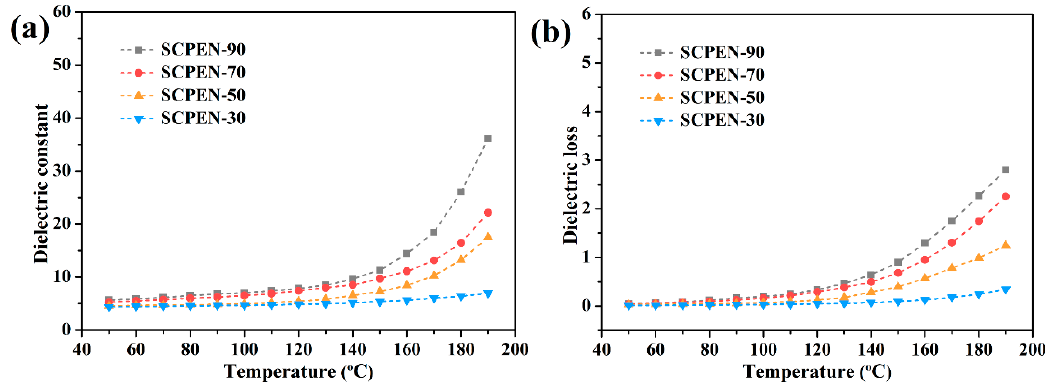
Figure 7. The temperature dependencies of ( a ) dielectric constant and ( b ) dielectric loss of SCPEN films at 1 kHz.